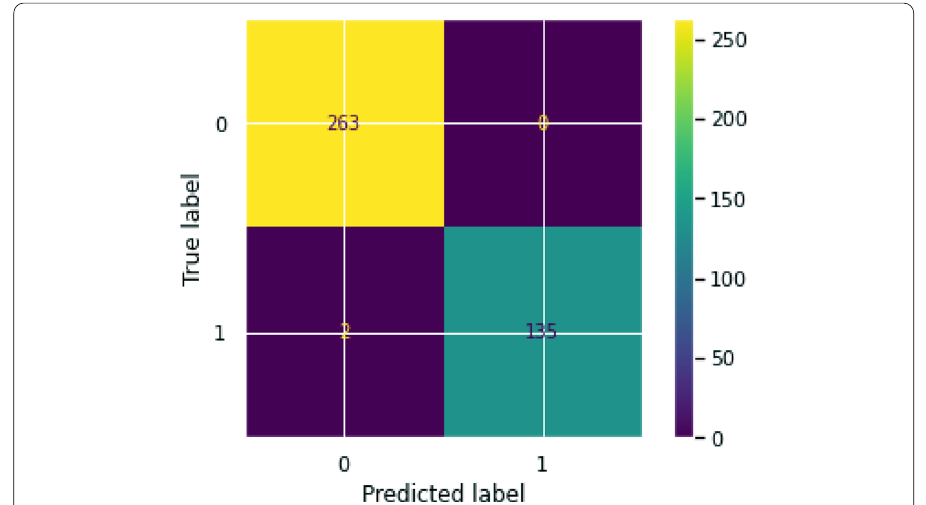
Fig. 17 Output: Confusion matrix of the proposed algorithm applied to the Dataset2